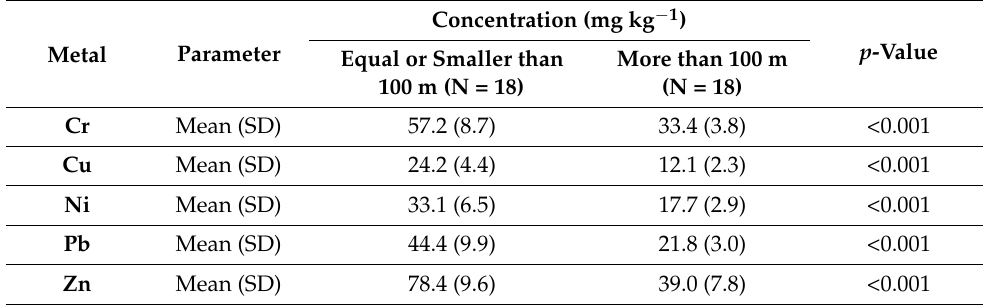
Table 3. Comparison of elements from the forest against